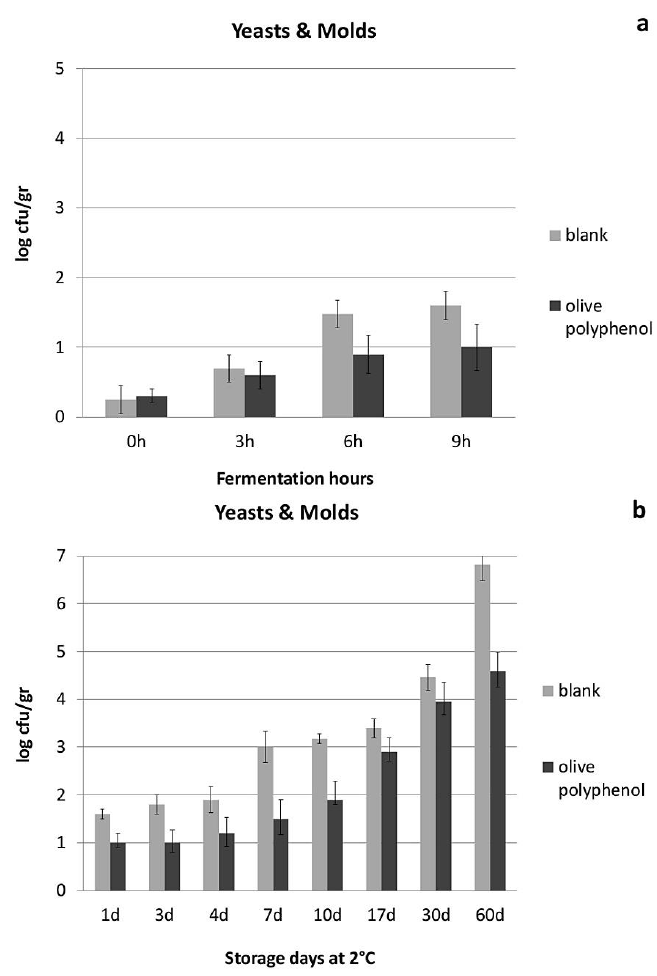
Figure 4. Population of Lactobacillus bulgaricus during fermentation ( a ) and refrigerated storage ( b ) of yogurts with or without addition of 1250 ppm of olive polyphenols.